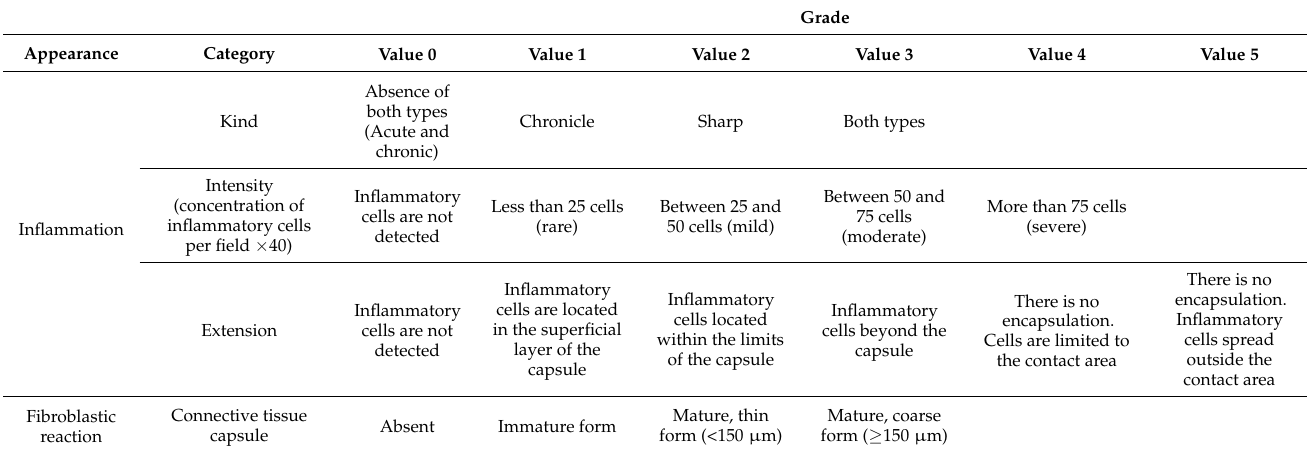
Table 1. Criteria used to carry out the evaluation. They are based in Taha et al. but they were slightly modified in our evaluation.